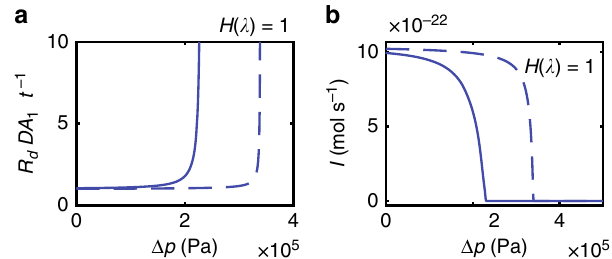
Fig. 7 The impact of pressure on PD resistance and transport. a Normalized diffusion resistance R d DA 1 t − 1 (Solid line) plotted as a function of turgor pressure difference Δ p . b Diffusion current Δ c ( R d ) − 1 plotted as a function of turgor pressure difference Δ p for a concentration difference Δ c = 10 μ M (Solid line). The transport currents decline in sync with increasing resistance. Dashed lines show results without steric interactions, i.e. H ( λ ) = 1. We use s = 0.9nm for the Stokes diameter of common fl uorescent dyes